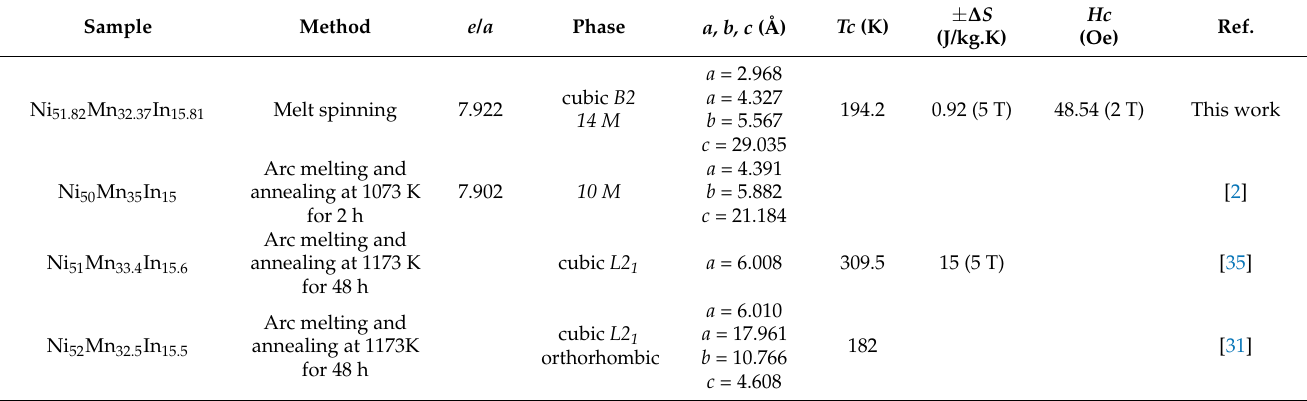
Table 1. Comparison of the obtained physical properties of Ni 51.82 Mn 32.37 In 15.81 ribbons with ear- lier